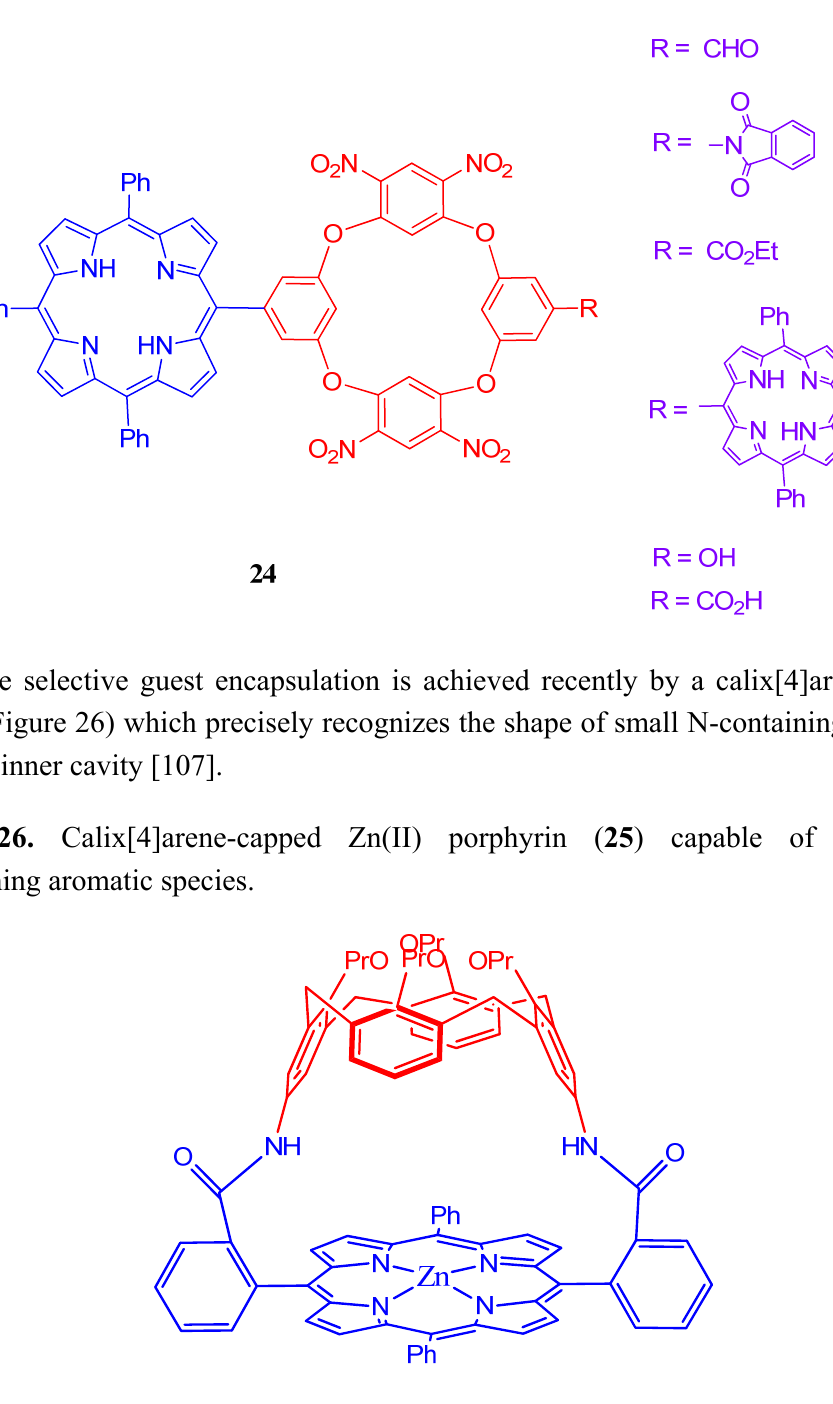
Figure 25. Schematic representation of functionalized oxacalix[4]arene porphyrins, 24 .